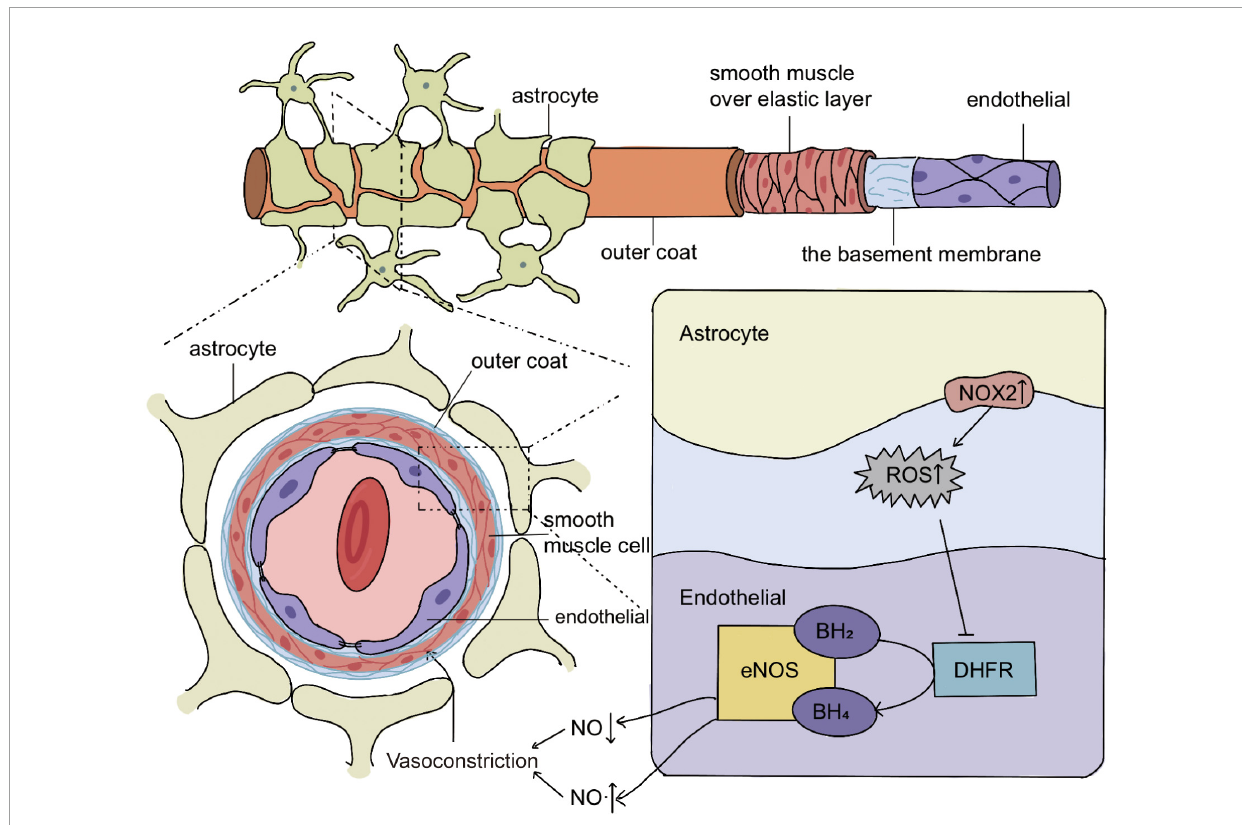
FIGURE6 Schematic representation of the molecular mechanism of eNOS uncoupling in acute vasoconstriction after subarachnoid hemorrhage (SAH). In SAH, the increased expression of NOX2 in astrocytes causes the cells to release excess H 2 O 2 , and H 2 O 2 enters the endothelial cells to reduce the expression of DHFR, which leads to the decrease of BH 4 , a key cofactor of eNOS. The decrease of BH 4 increases the uncoupling of eNOS and reduces its production of NO. This leads to acute cerebral ischemia after SAH, most likely by mediating acute